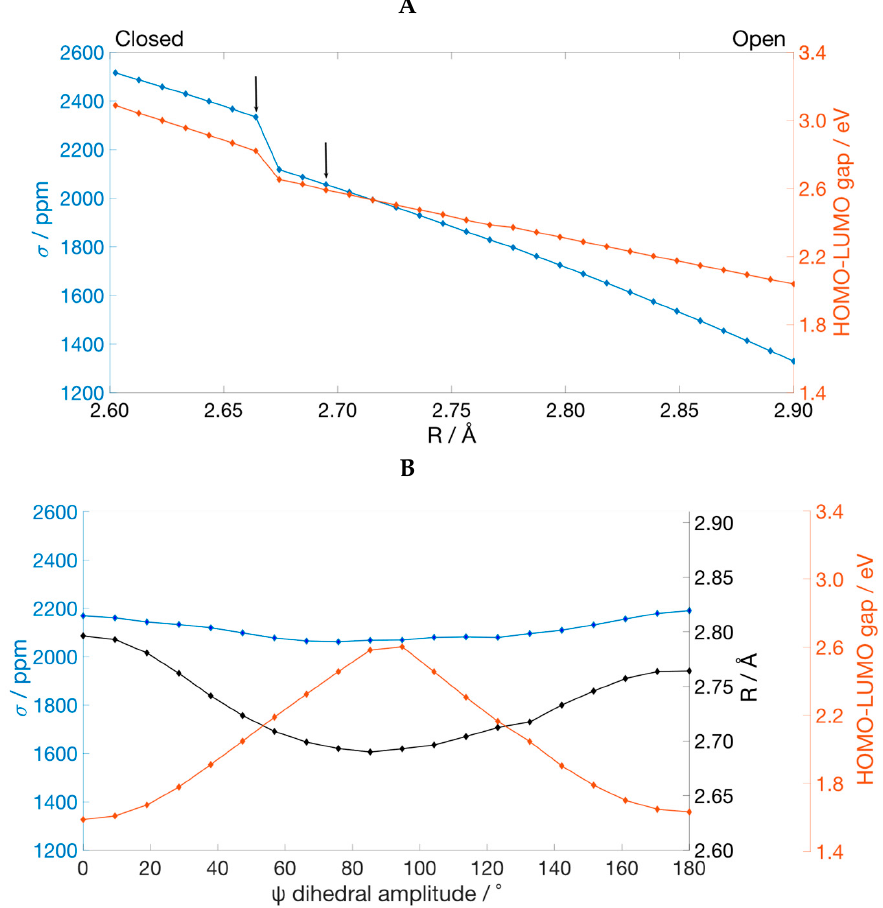
Figure 6. ( A ) Values of the 125 Te isotropic shielding constant and of the HOMO-LUMO gap of Ph 2 Te 2 at different Te-Te distances. The two arrows indicate the points at which the two fully optimized closed and open conformers are located. ( B ) Values of the 125 Te isotropic shielding constant, of the Te-Te distance (R) and of the HOMO-LUMO gap of Ph 2 Te 2 at different values of the Ψ dihedral angle. Level of theory: ZORA-OPBE/QZ4Pae//ZORA-OPBE/TZ2P.